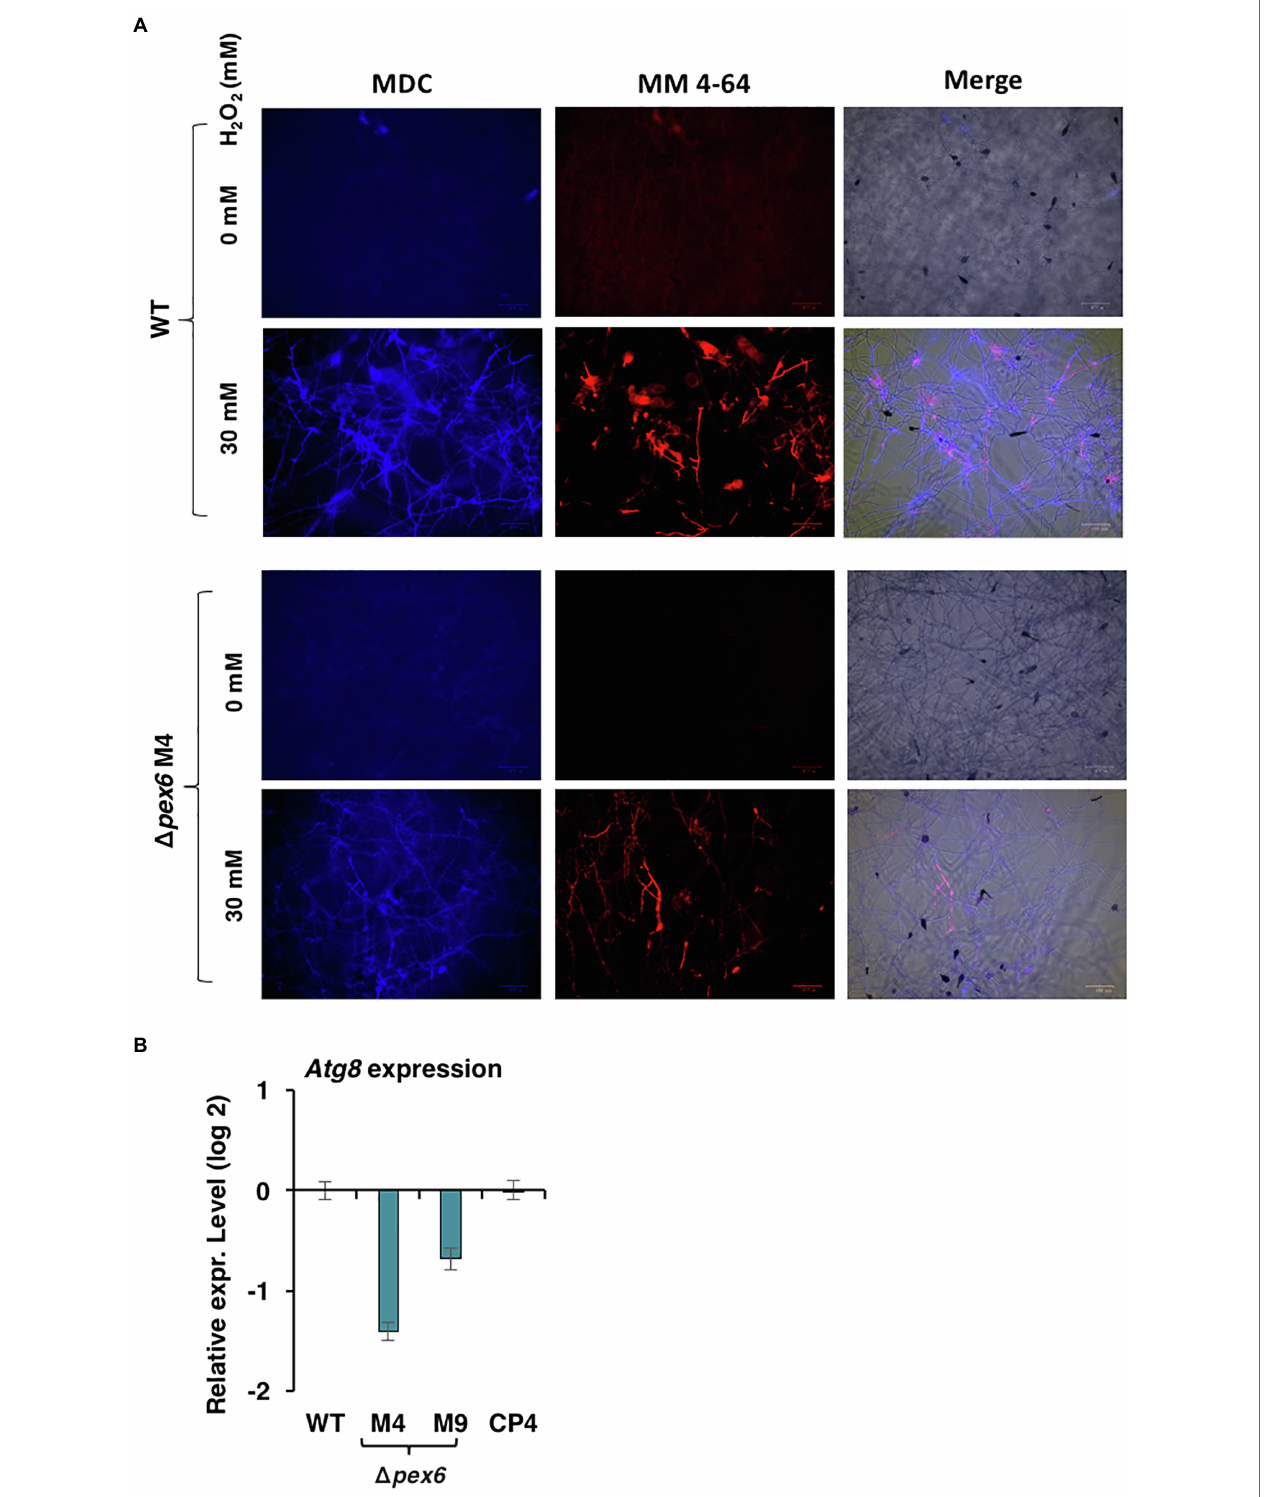
FIGURE 11 | Pex6 impacts autophagy process triggered by hydrogen peroxide (H 2 O 2 ) in A. alternata . (A) Hyphae of WT and ∆ pex6 -M4 grown in PDB with or without H 2 O 2 for 4 h were co-stained with monodansylcadaverine (MDC) and MM 4–64. Δ pex6 hyphae display much weaker fluorescence than wild-type, suggesting that Pex6 plays a role in autophagy process. (B) Quantitative real-time PCR analysis of the expression of an atg8 gene encoding an autophagy-related protein in the WT, the pex6 -deficient ( ∆ pex6 -M4 and M9), and the CP4 complementation